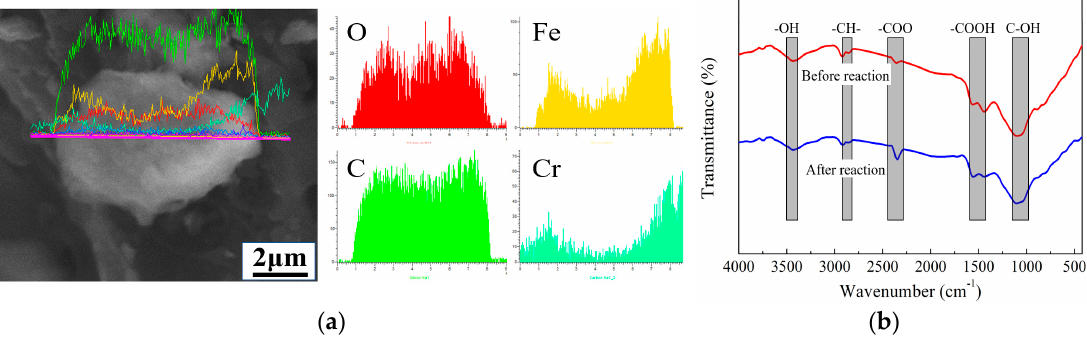
Figure 5. ( a ) SEM and EDX line scanning analysis of BC-nZVI after reaction and ( b ) FTIR spectra of BC-nZVI, before and after reaction.